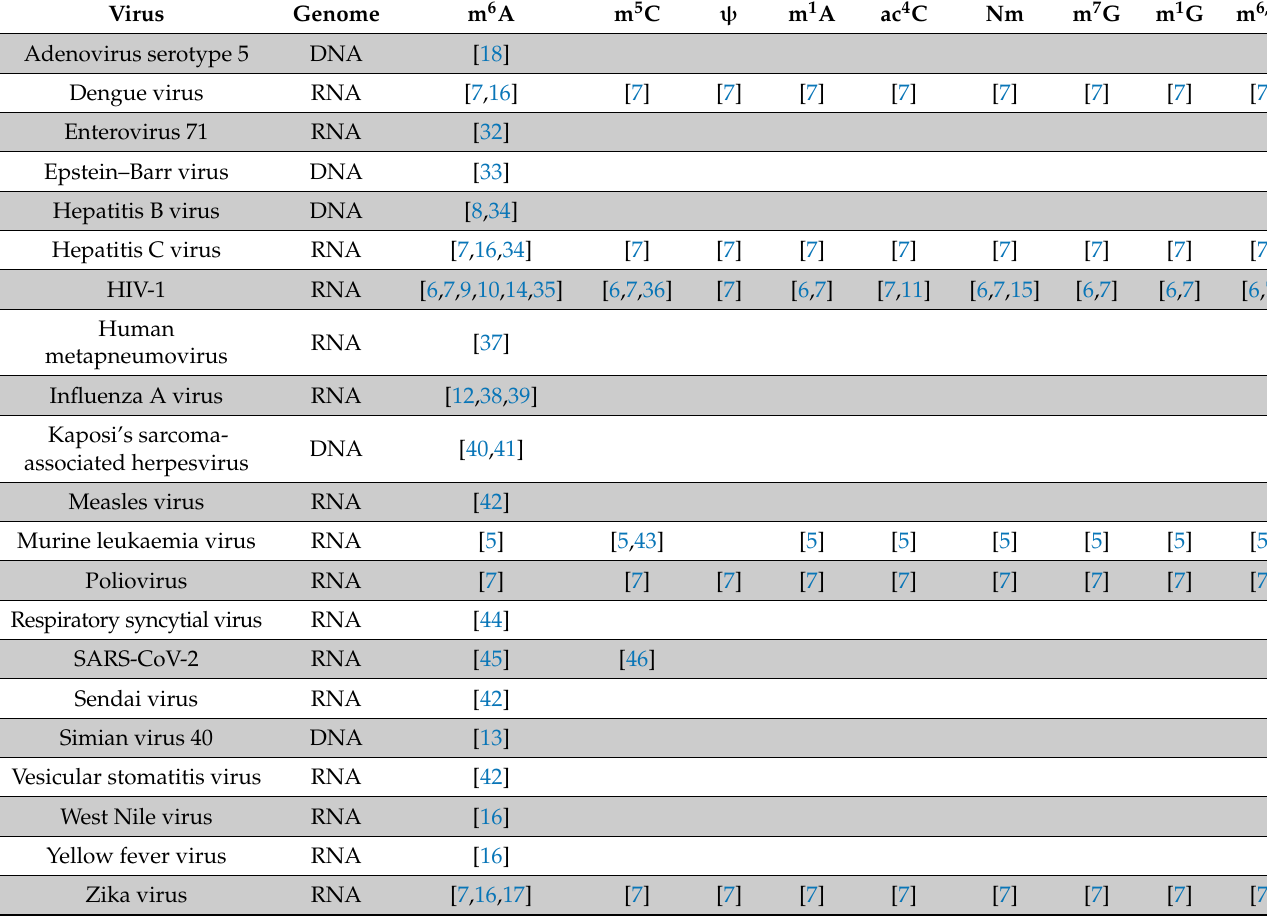
Table 2. A summary of viruses that have previously been reported to carry some of these nine common RNA modifications on virally encoded